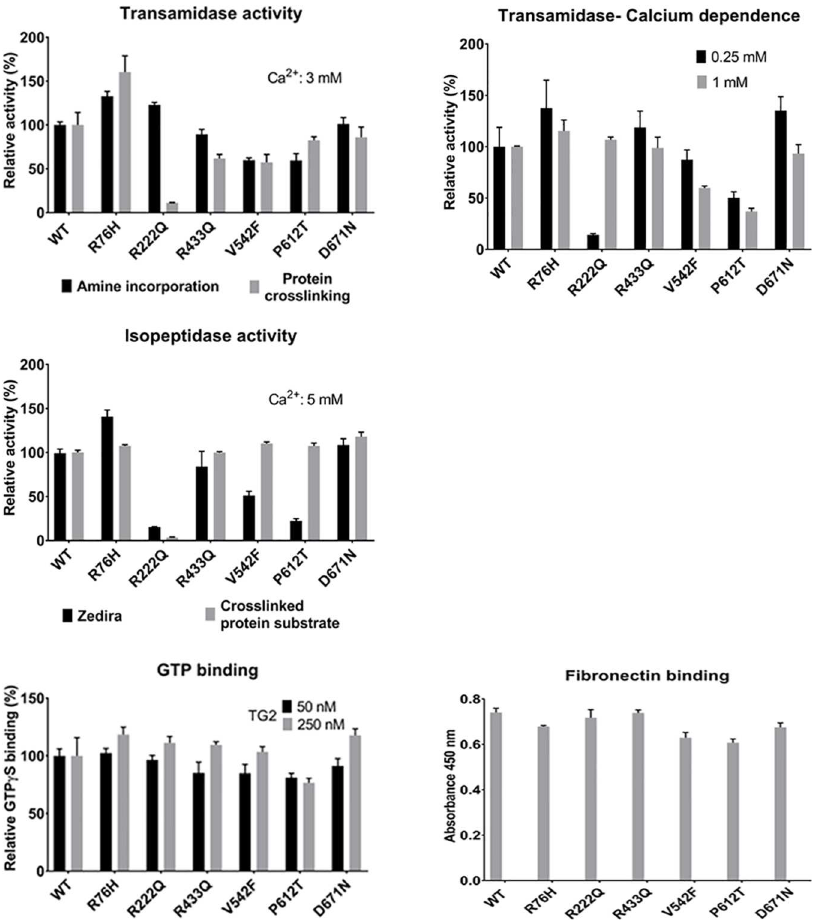
Fig 3. Biochemical characterization of the six homozygous nsSNVs of TGM2. Kinetic characterization of the transamidase activity of TGM2 variants and wild type at 3 mM CaCl 2 concentration using amine incorporation assay [56] and protein crosslinkingassay [17]. Calcium dependence of kinetic transamidase reactionwith 0.25 and 1 mM calcium concentrations using amine incorporation assay. Comparisonof the kinetic isopeptidase activity of TGM2 variants at 5 mM CaCl 2 concentration using Zedira assay and crosslinked protein substrate [18]. The relativeactivities are calculatedas a percentage of the activity values of the wild type TGM2. Comparison of BODIPY FL GTP γ S bindingof variants and wild type TGM2 proteins with different concentrations of TGM2 (50 and 250 nM). The changein the fluorescence intensity (Ex/Em: 485/520nm) was determinedafter 15 minutes of incubation. Bindingis shown as a percentage of maximum bindingin case of wild type TGM2 [29]. The Fibronectinbindingpropertyof the TGM2 variants was tested using a previouslypublisheddirect ELISA assay [16]. Data are presentedas means with ± standard deviations from three separate experiments donein triplicate. All the data were analyzedby GraphPad